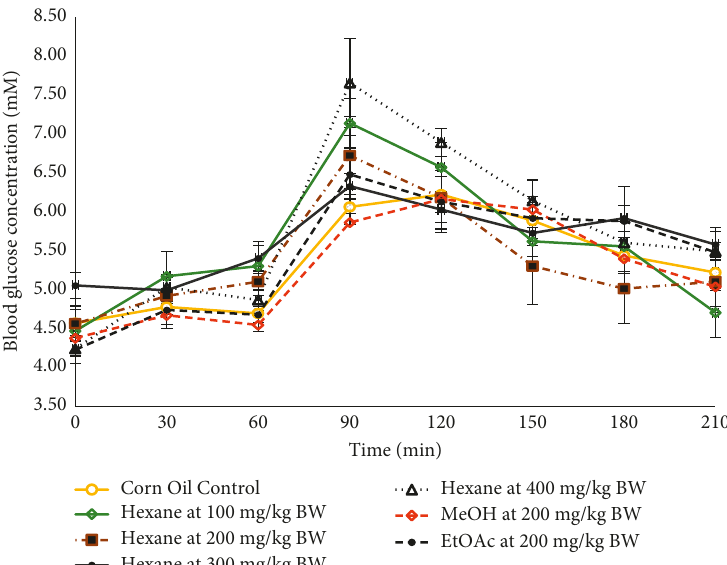
Figure 3: The OGTT of the crude extracts when administered orally versus corn oil control ( n � 6). EtOAc – ethyl acetate and MeOH –